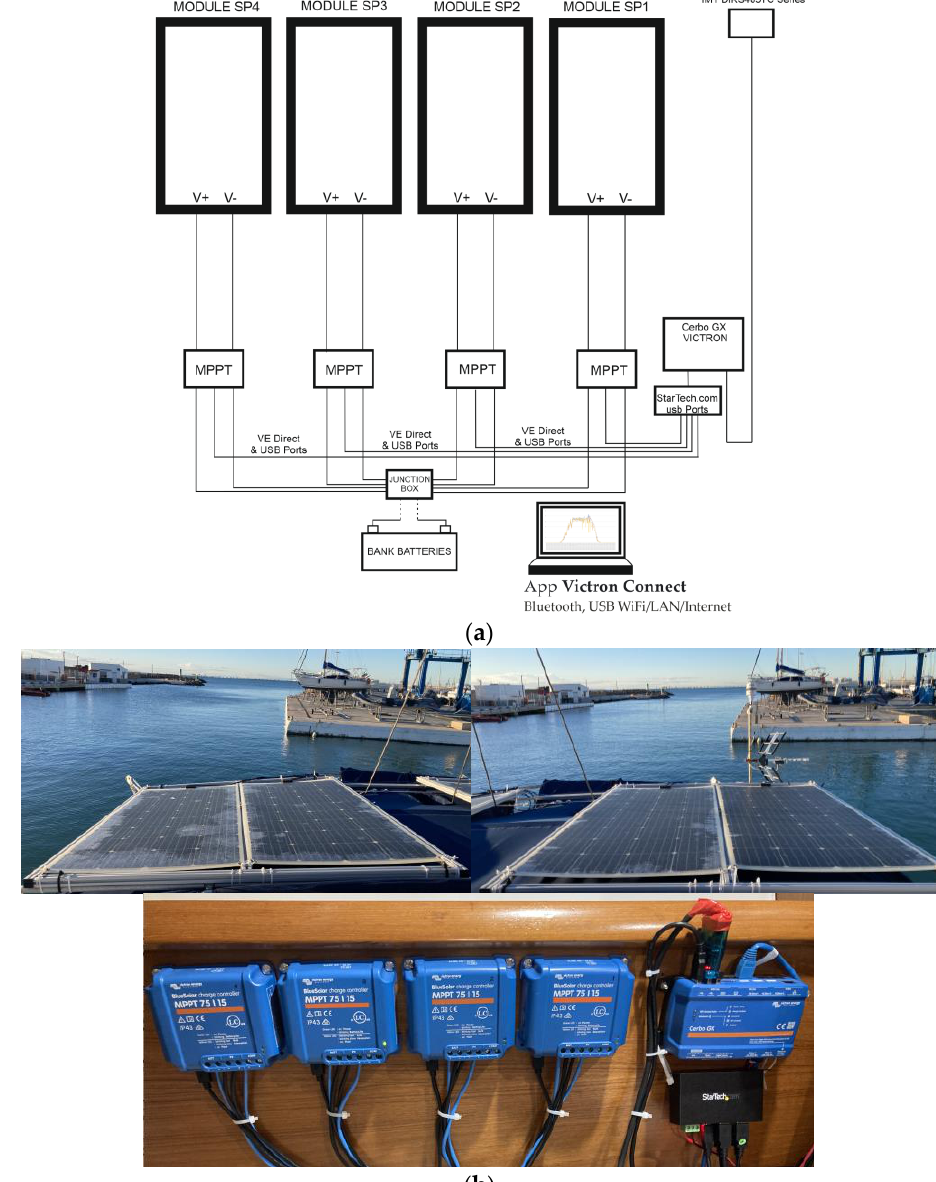
Figure 13. PV system installation: ( a ) schematic diagram; ( b ) actual assembly.